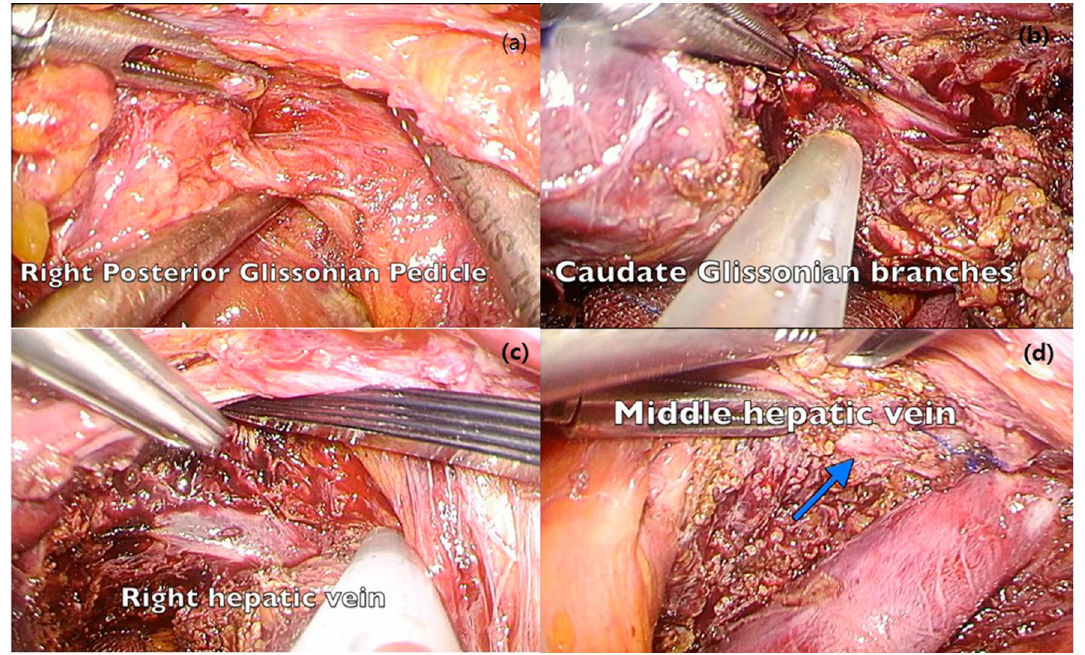
Figure 3. Photos taken from laparoscopic caudate lobectomy ( a ) The right posterior glissonian pedicle was isolated and temporarily clamped. ( b ) The caudate glissonian branches were identified and controlled. ( c The exposure of right hepatic vein. ( d ) After complete resection of caudate lobe, the exposure of middle hepatic vein.